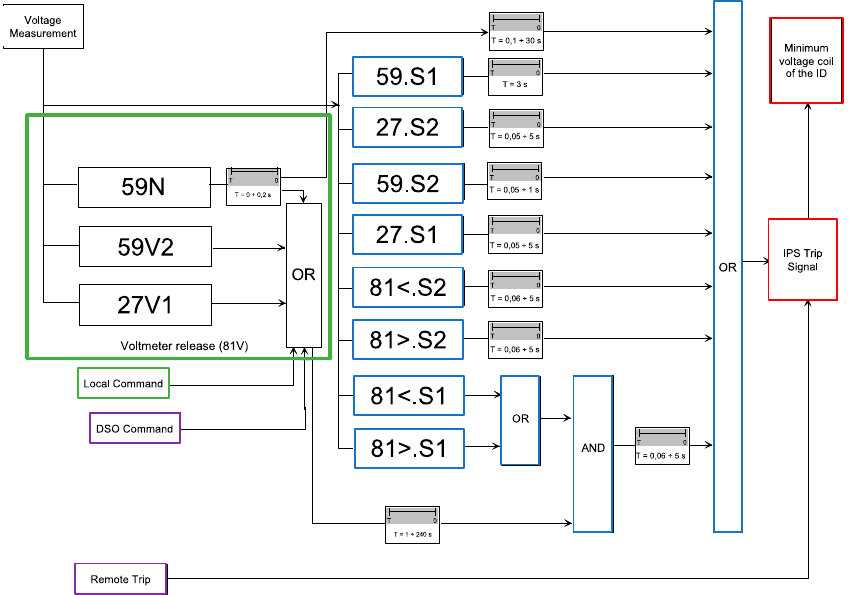
Figure A1. IPS protection functions defined by the current Italian regulatory framework. Blue blocks represent functions which are locally implemented by IPs. Green blocks represent functions which can be either implemented locally by IPs, or, remotely, from other protections installed in the system, or by remote commands (e.g., by the DSO). Purple blocks represent functions that are implemented remotely by the DSO. Red blocks represent local signals which must be coordinated between all the installed IPs and IDs.